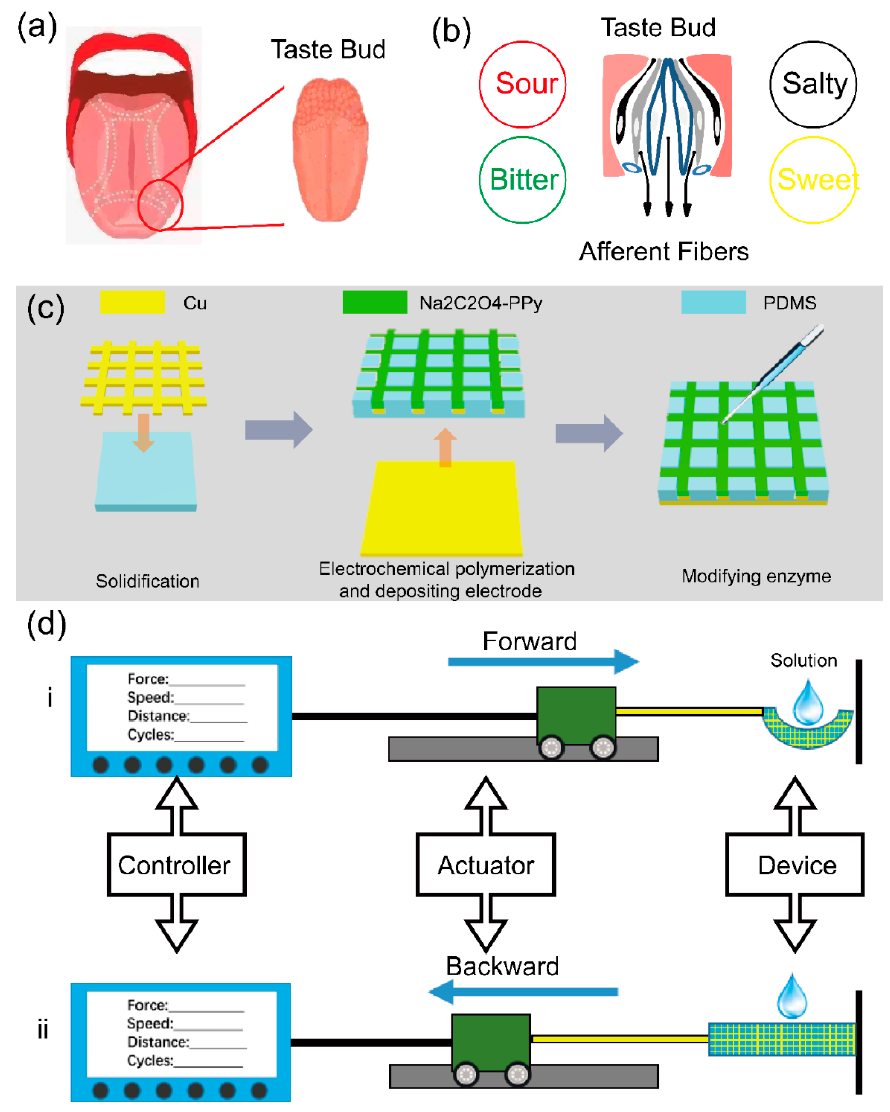
Figure 1. ( a ) Taste receptor: taste bud. ( b ) Gustation recognition. ( c ) The fabrication of the device. ( d ) The measurement system.